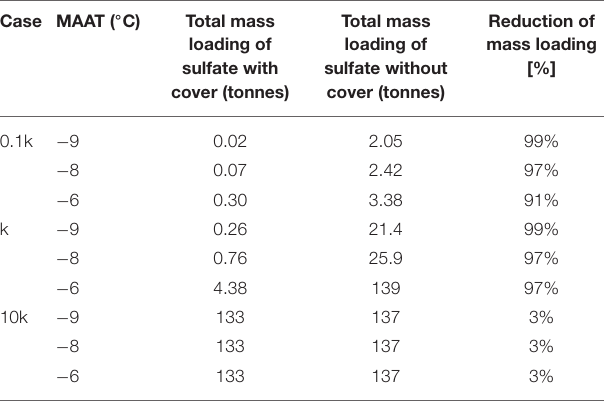
TABLE 3 | Sensitivity analysis to climate warming for all simulation cases ( k refers to k ref FeS ) (no cover). 2